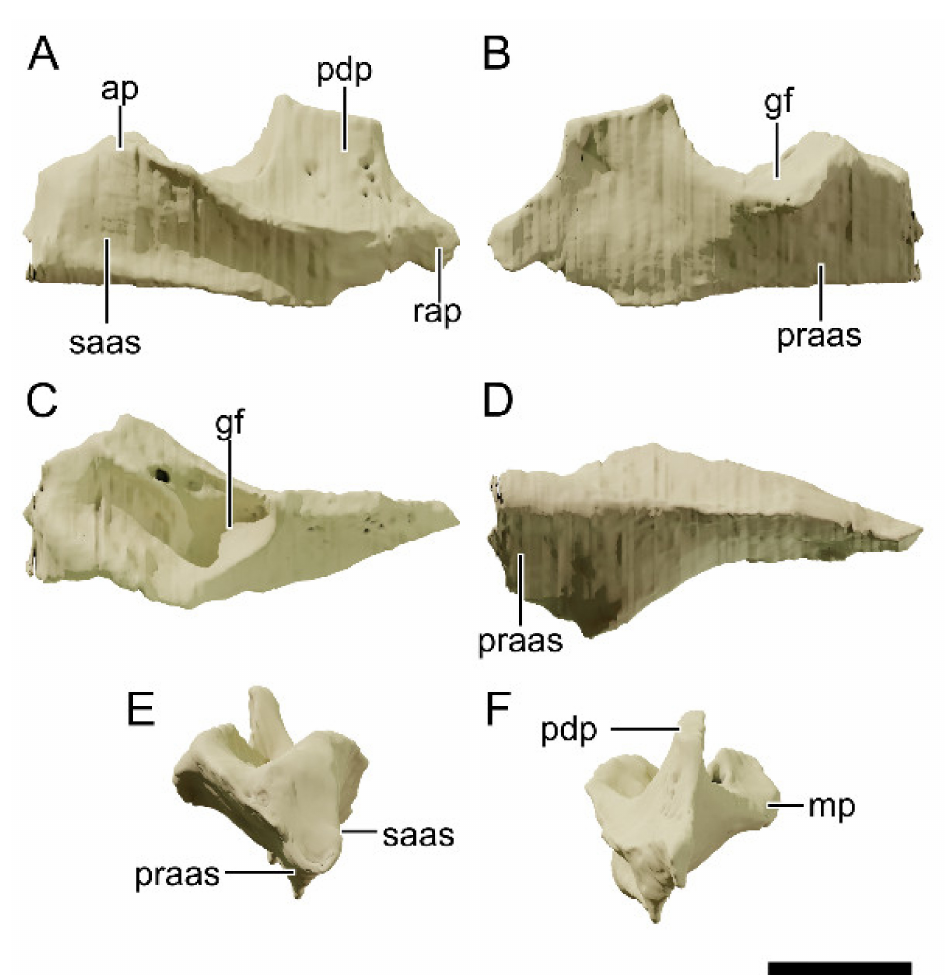
Figure 32. Digital reconstruction of the left articular of NHMD 164758. ( A ) Lateral view. ( B ) Medial view. ( C ) Dorsal view. ( D ) Ventral view. ( E ) Anterior view. ( F ) Posterior view. Abbreviations: ap, anterior process; gf, glenoid fossa; mp, medial process; pdp, posterodorsal process; praas, articular surface for the prearticular; rap, retroarticular process; saas, articular surface for the surangular. Scale bar = 10